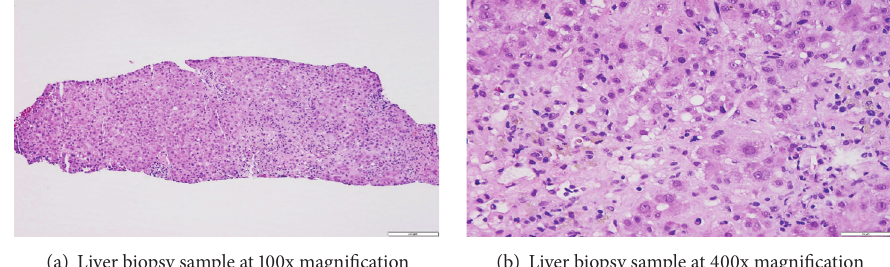
Figure 2: On Hematoxylin and Eosin stain (100x and 400x), there is centrilobular and bridging necrosis accompanied by portal and lobular inflammation including eosinophils and plasma cells. There is evidence of cholestasis and bile duct injury is noted in some portal tracts. Hepatocellular injury, that is, hepatocyte ballooning degeneration, is also present. Fibrosis is absent on Trichrome staining. There is no evidence of steatosis, glycogenic nuclei, Mallory’s hyaline, or copper deposition. Overall, these findings favor a diagnosis of drug-induced liver